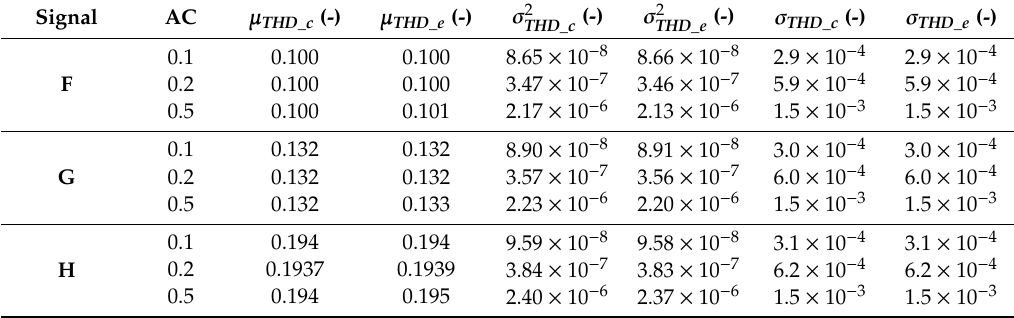
Table 7. Results of the test vs. harmonic amplitude, all at 5% of the 50 Hz